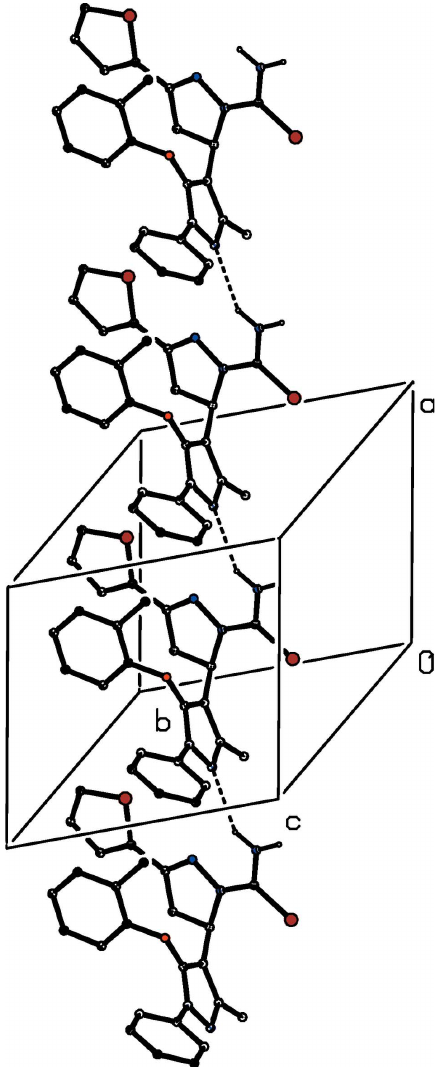
Figure 6 Part of the crystal structure of compound (Ia) showing the formation of a hydrogen-bonded chain running parallel to the [100] direction. Hydrogen bonds are drawn as dashed lines and, for the sake of clarity, the H atoms which are bonded to C atoms have been omitted.